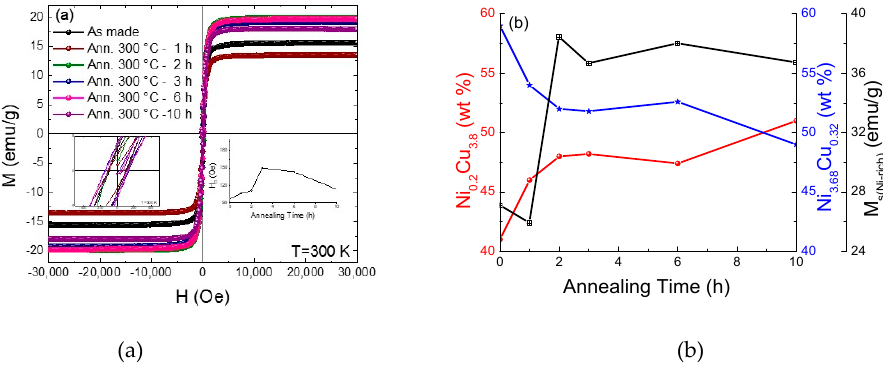
Figure 3. ( a ) Hysteresis loops of the synthesized Ni-Cu nanoparticles at T = 300 K. Inset figures represent the dependence of H c and M r on annealing time. ( b ) Ni-rich / Cu-rich phase ratios and Ni-rich normalized saturation magnetization dependence on annealing time.